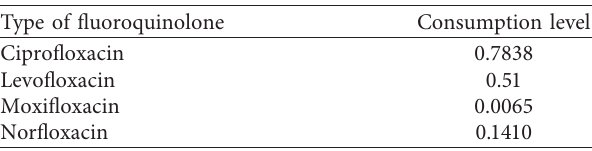
Table 2: Level of global fluoroquinolone consumption according to the drug type during